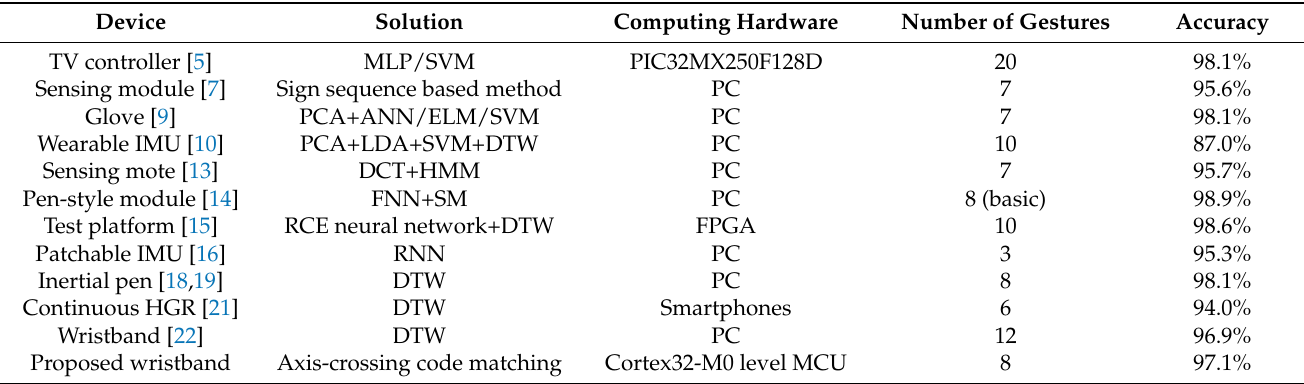
Table 1. Summary of several typical